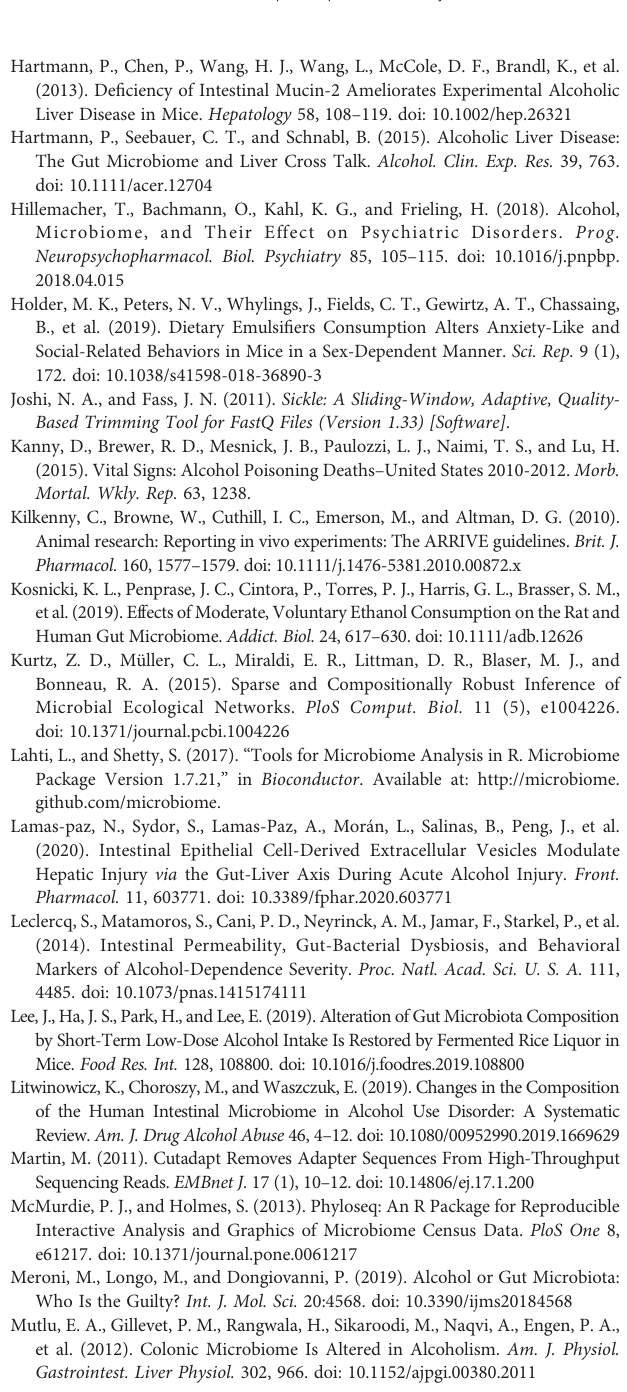
Supplementary Figure 2 | Best subset of identi fi ed microbiota markers, as reported in Figure 2. Histograms report relative abundance distribution among individual samples, grouping samples in the T1 alcohol and T1 water administered rats, and the corresponding T0 rats. The best marker were identi fi ed by evaluating their prevalence (i.e. the presence in multiple samples of a class) and relative abundance (i.e. by evaluating mean and median group abundances, reported as solid and dashed lines, respectively). Supplementary Figure 3 | Microbiota association network on the alcohol intoxicated samples, comparing oral and i.p administration route of OEA. Image